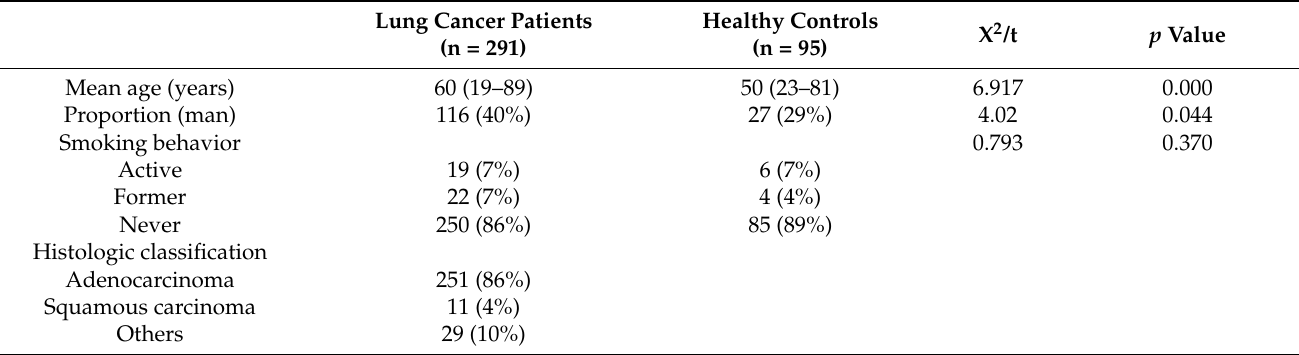
Table 1. Characteristics of the study population. Lung Cancer